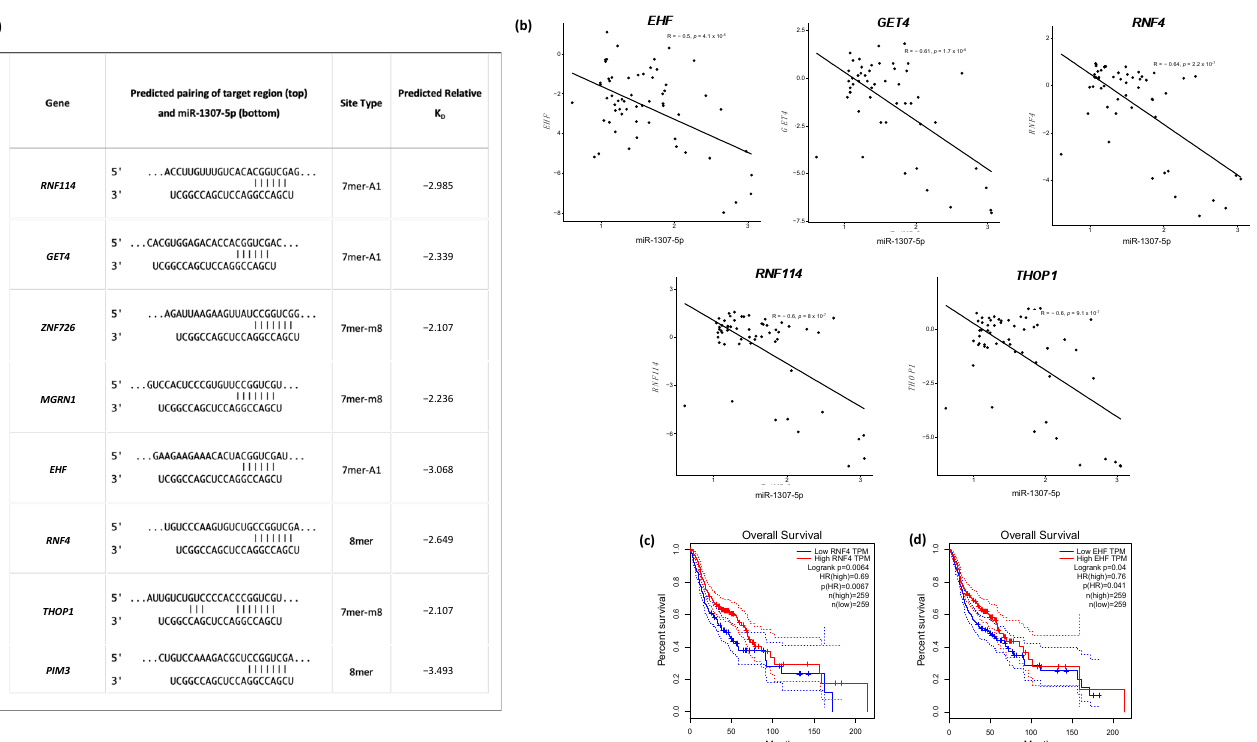
Figure 5. Predicted targets of miR-1307-5p show an inverse correlation with miR-1307-5p expression and predict overall survival in OSCC patients. ( a ) Table of predicted binding sites of target genes and miR-1307-5p, along with their respective predicted KD values; ( b ) Pearson’s correlation analysis using RNASeq expression data and the expression data in TCGA_HNSC to identify inversely correlated genes. Overall survival analyses were performed using the GEPIA platform where patients with ( c ) RNF4 and ( d ) EHF expression above the median are indicated by red lines, and patients with gene expression below the median are indicated by black lines. Log-rank p < 0.05 was considered to indicate a statistically significant difference. Table 1. Expression of the predicted target genes of miR-1307-5p in TCGA dataset and the RNASeq data generated in this study.